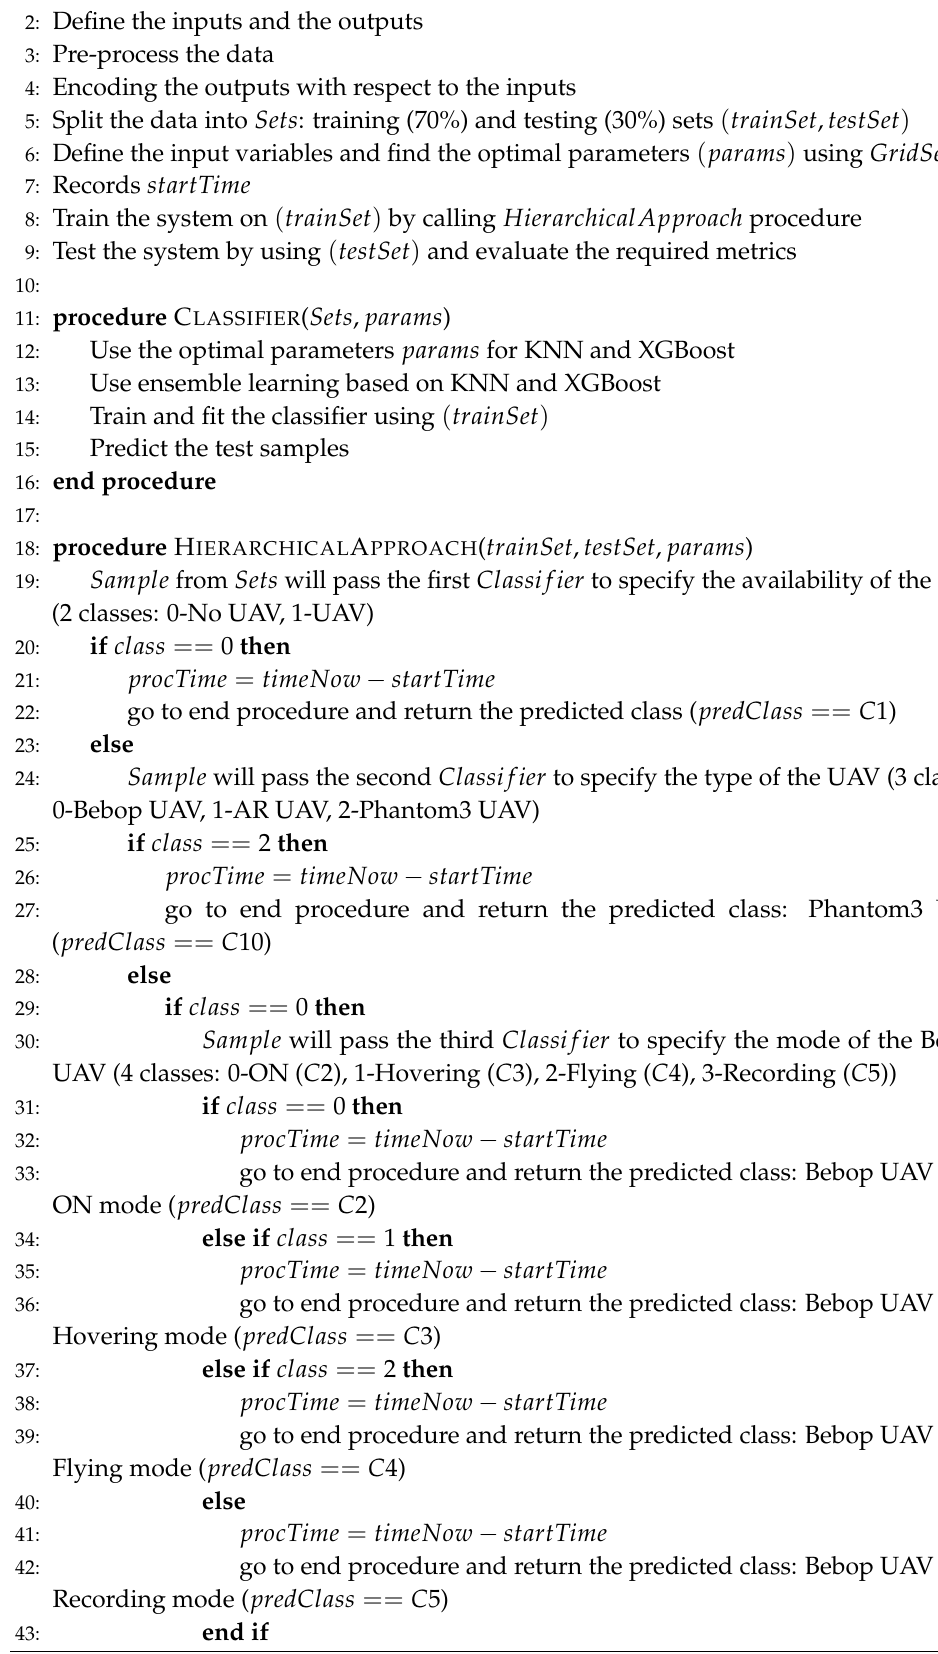
Algorithm 1 Hierarchical learning